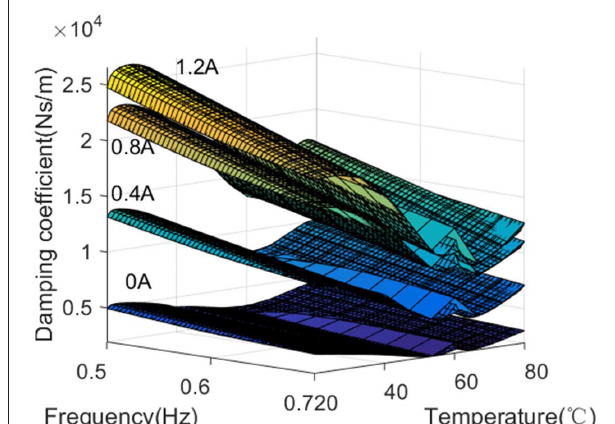
FIGURE 7 | Equivalent damping characteristics.